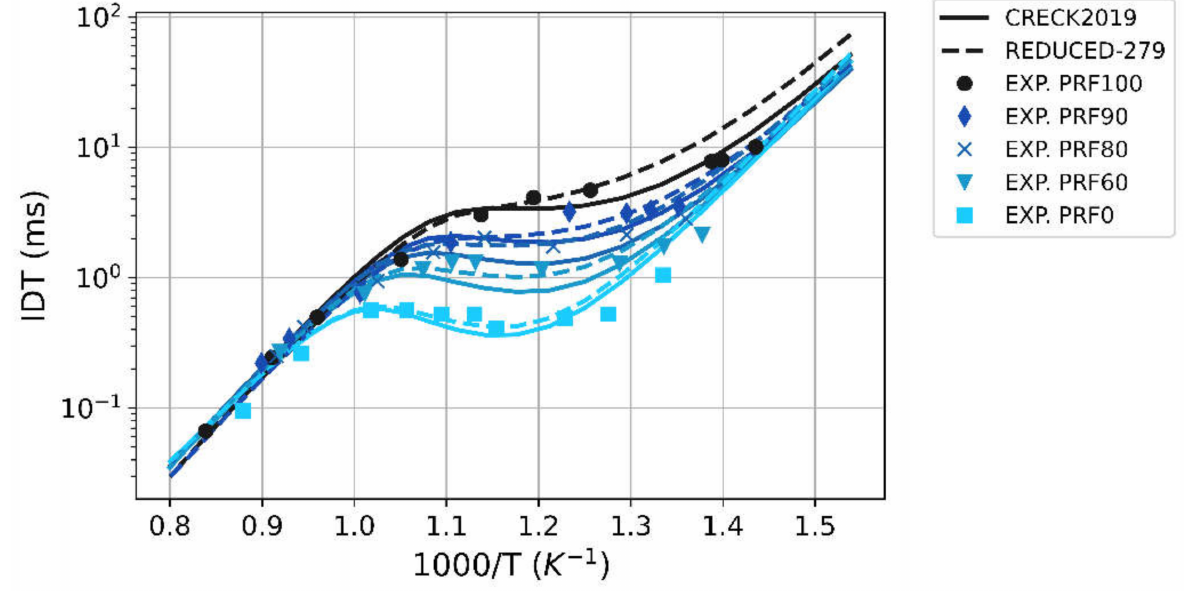
Figure 2. Comparison between experimental (markers) and simulated (lines) ignition-delay time vs. inverse temperature for different PRF surrogates. Simulation results from the complete kinetics scheme are solid lines, those from the reduced scheme are dashed